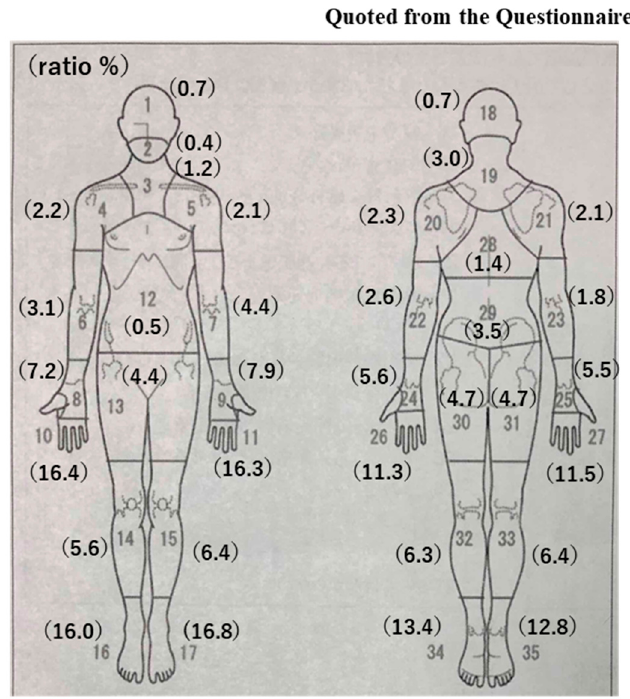
Figure A2. Prevalence of numbness by site.